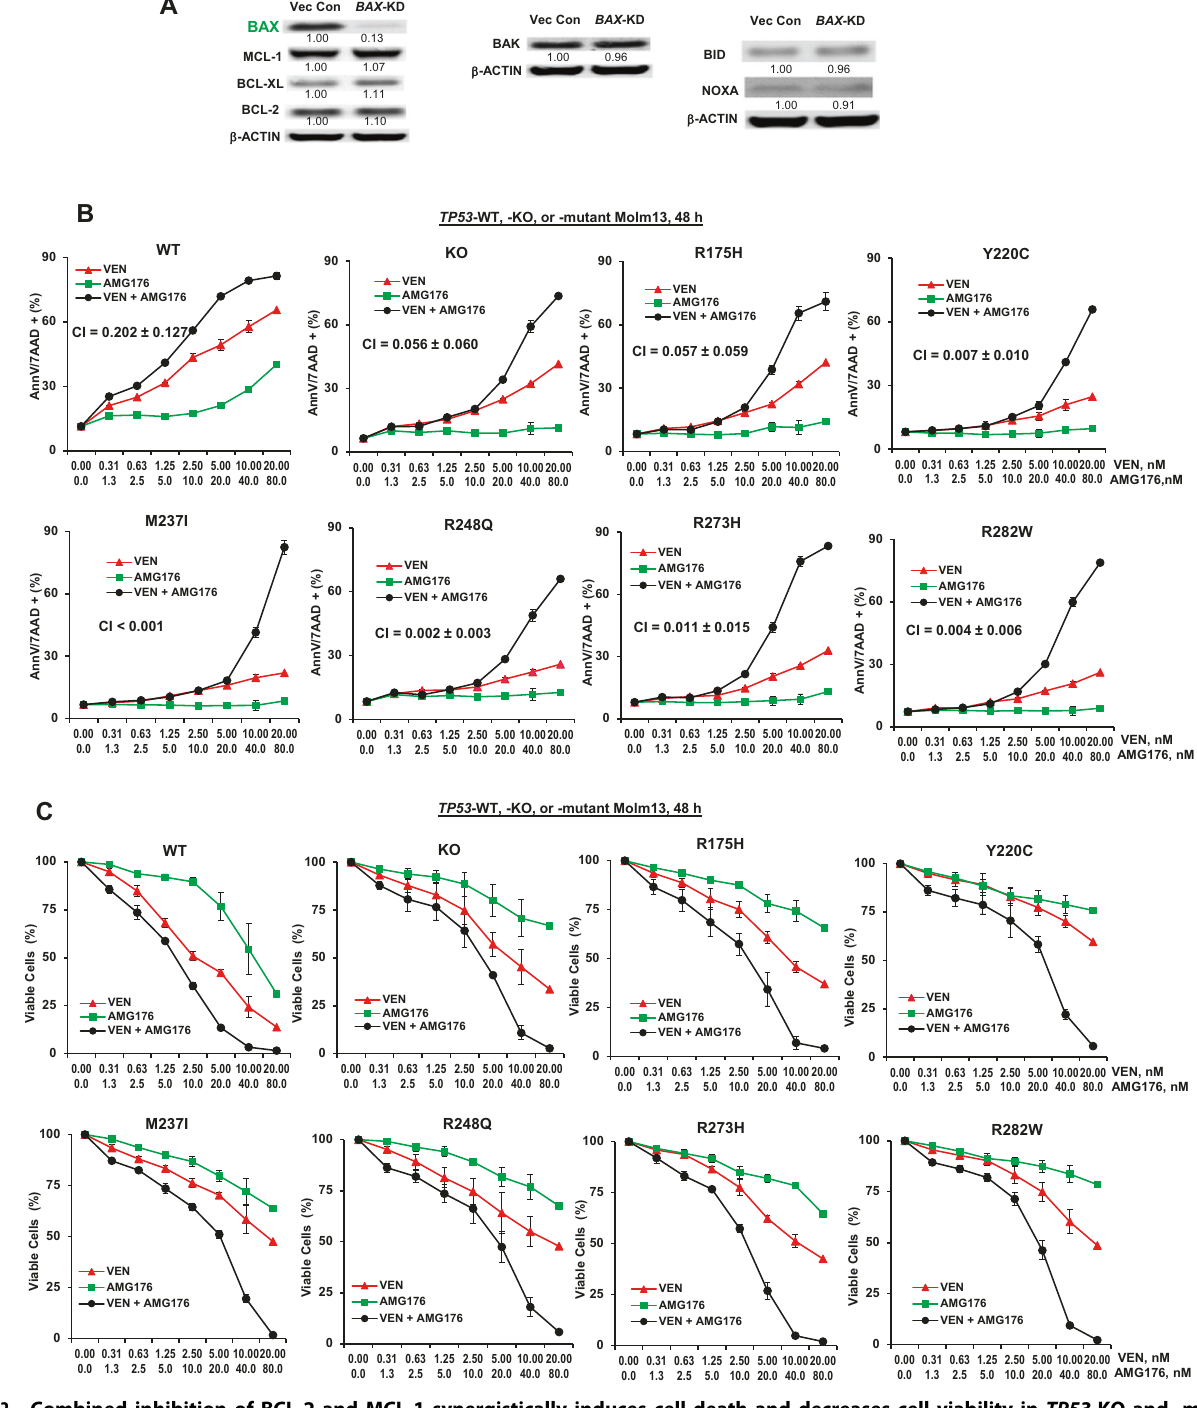
Fig. 2 Combined inhibition of BCL-2 and MCL-1 synergistically induces cell death and decreases cell viability in TP53 -KO and -mutant cells. A Western blotting of BCL-2 family proteins in vector control (Vec Con) and BAX -KD Molm13 cells. B , C TP53 -WT, -KO, and -mutant Molm13 cells were treated with VEN, AMG176, or both for 48 h. Cell death ( B ) and cell viability ( C ) in the WT control cells and the TP53 -KO and TP53 -mutant cells were determined by fl ow cytometry. Experiments were performed in triplicate. Error bars represent the mean ± SEM of three independent experiments. h hour, AnnV annexin V, 7AAD 7-aminoactinomycin